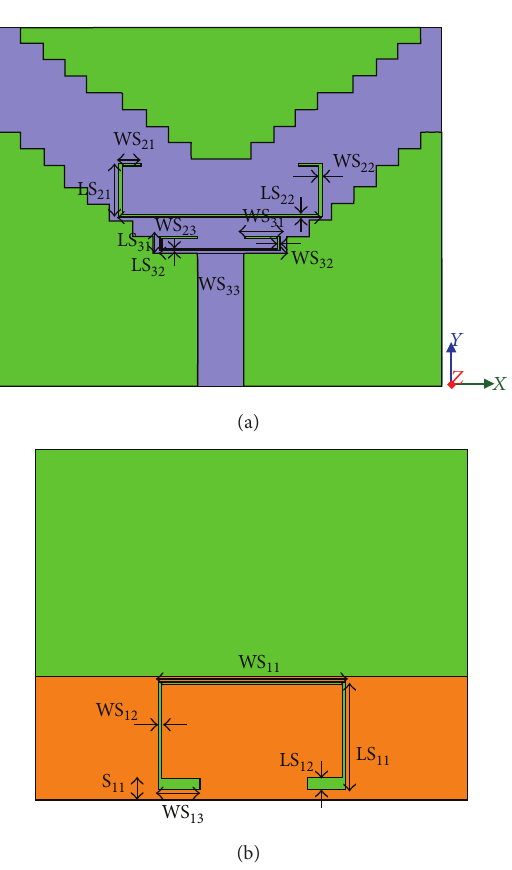
Figure 2: Simulated VSWR of the reference antenna without band- rejected characteristics.